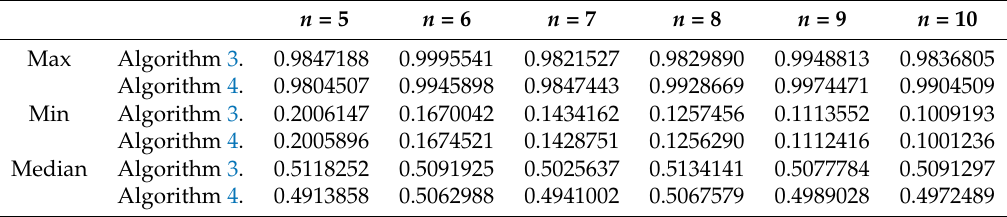
Table 1. The Choquet integral of alternative ( 1/ n ,2/ n , . . . ,1 ) . n =